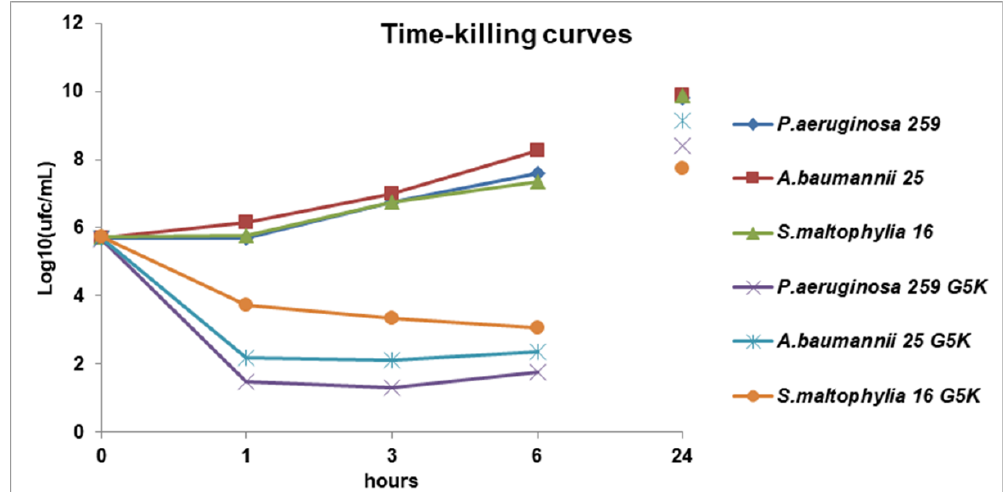
Figure 1. Time-killing curves performed with G5K (at concentrations equal to 4 × MIC) on P. aeruginosa 259, S. maltophilia 16, and A. baumannii 25.